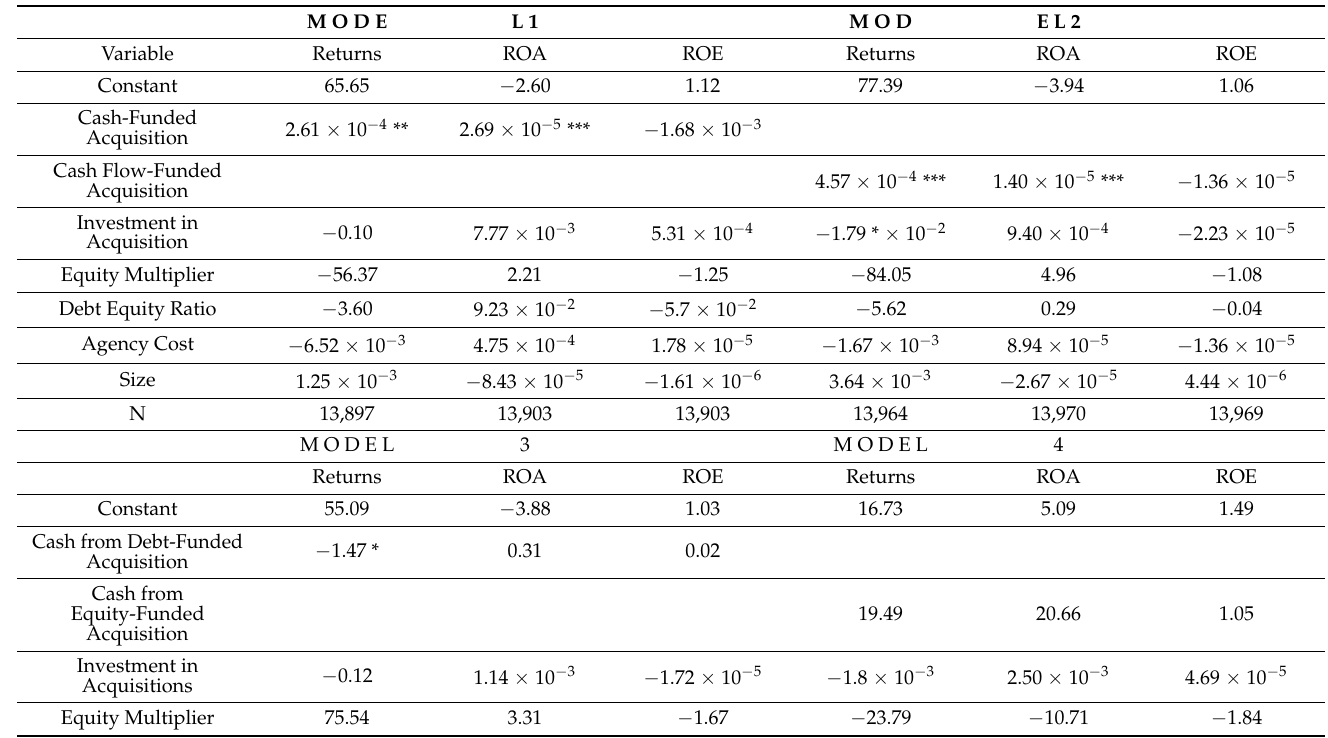
Table 10. Robustness Tests: GMM Estimator Regressions of Returns, ROA, and ROE, on Cash, Cash Flow, with Acquisition Size, Debt Equity Ratio, Equity Multiplier, Short Term Debt, and Total Assets as